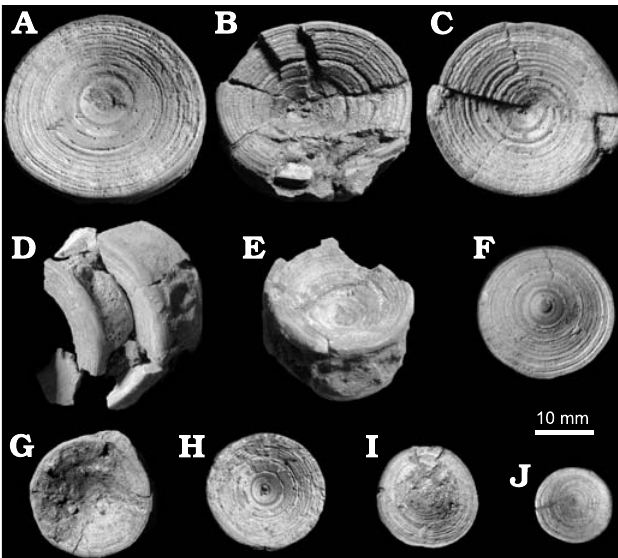
Fig. 7. Posteriormost precaudal and caudal vertebrae of the mackerel shark Carcharomodus escheri (Agassiz, 1843), MNU 071-20, from Groß Pampau, the middle–late Miocene, from anterior ( A ) to posterior ( J ). Table 2. Tooth measurements (in cm) of Carcharomodus escheri (Agassiz, 1843). Abbrevations: BCT, basal crown thickness; BCW, basal crown width: maximum crown width at the base of the crown; CH, crown height: maximum vertical enameloid height; DCL, distal crown edge length: straight line between the crown tip and distalmost point of the crown; DS, degree of slant: the angle between a line drawn perpendicular to a straight line touching the lower extensions of the enameloid and beginning at the midpoint of the crown width and a line beginning at the same point and passing through the tip of the enameloid; LCH, height of lateral cusplets: if they are multiple, the height of the tallest of the lateral cusplets has been measured; MCL, mesial crown edge length: straight line between the crown tip and mesialmost point of the crown; PCH, height of principle cusp; PCW, width of principle cusp; RA, angle between root lobes; RT, root thickness; RW, root width; TH, total height of tooth. Numbers in first row refer to teeth depicted in Figs. 10 and 11,